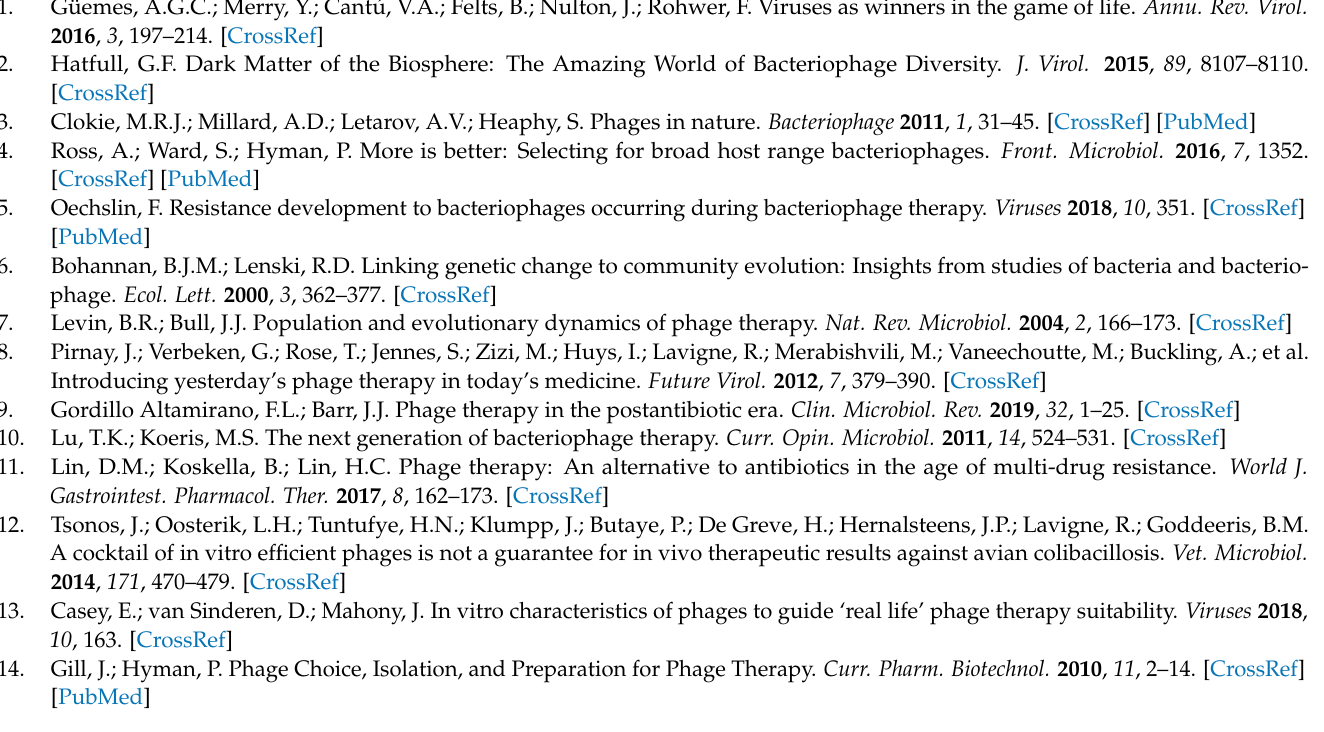
combinations at all MOIs. Figure S2: Principal component analysis (PCA) of the differences in the OD trajectories/values of the phage–host combinations. Figure S3: Growth dynamics curves for Group 3 subgroups. Table S1: Prophages identified in the APEC genomes. Table S2: Nonmetric multidimensional scaling (NMDS) grouping summary. Table S3: Nonmetric multidimensional scaling (NMDS) Group 3 subgrouping